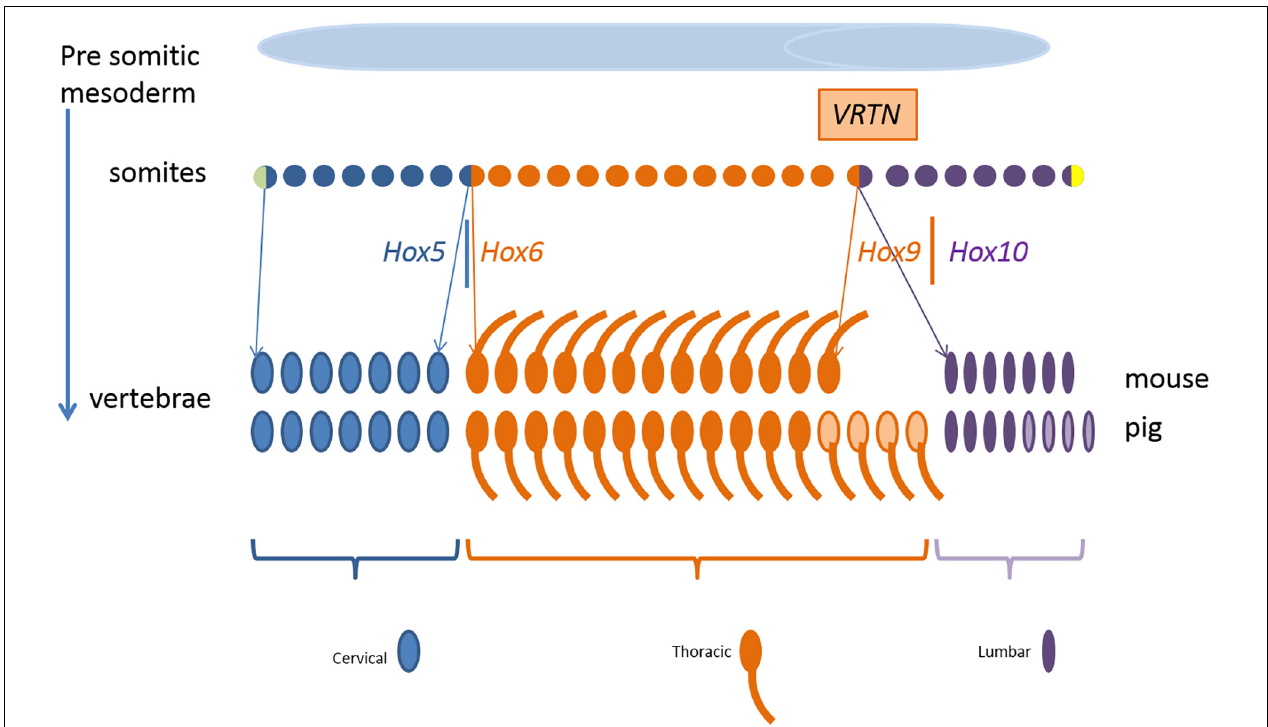
FIGURE 9 | Development of the mouse and pig vertebral pattern from somites. Genes involved in the regulation and their spatial expression in italics. Variation in number of thoracic and lumbar vertebrae in pigs is indicated in light color. Parts of the figure was adopted from Gilbert (2000).